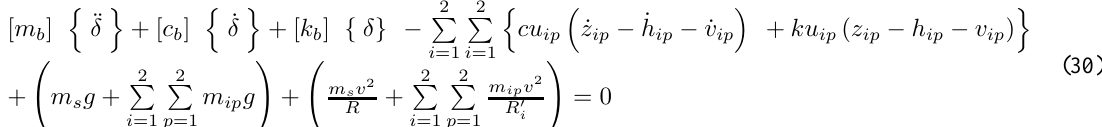
Fig. 6. 1st mode (flexural) shape of curved box